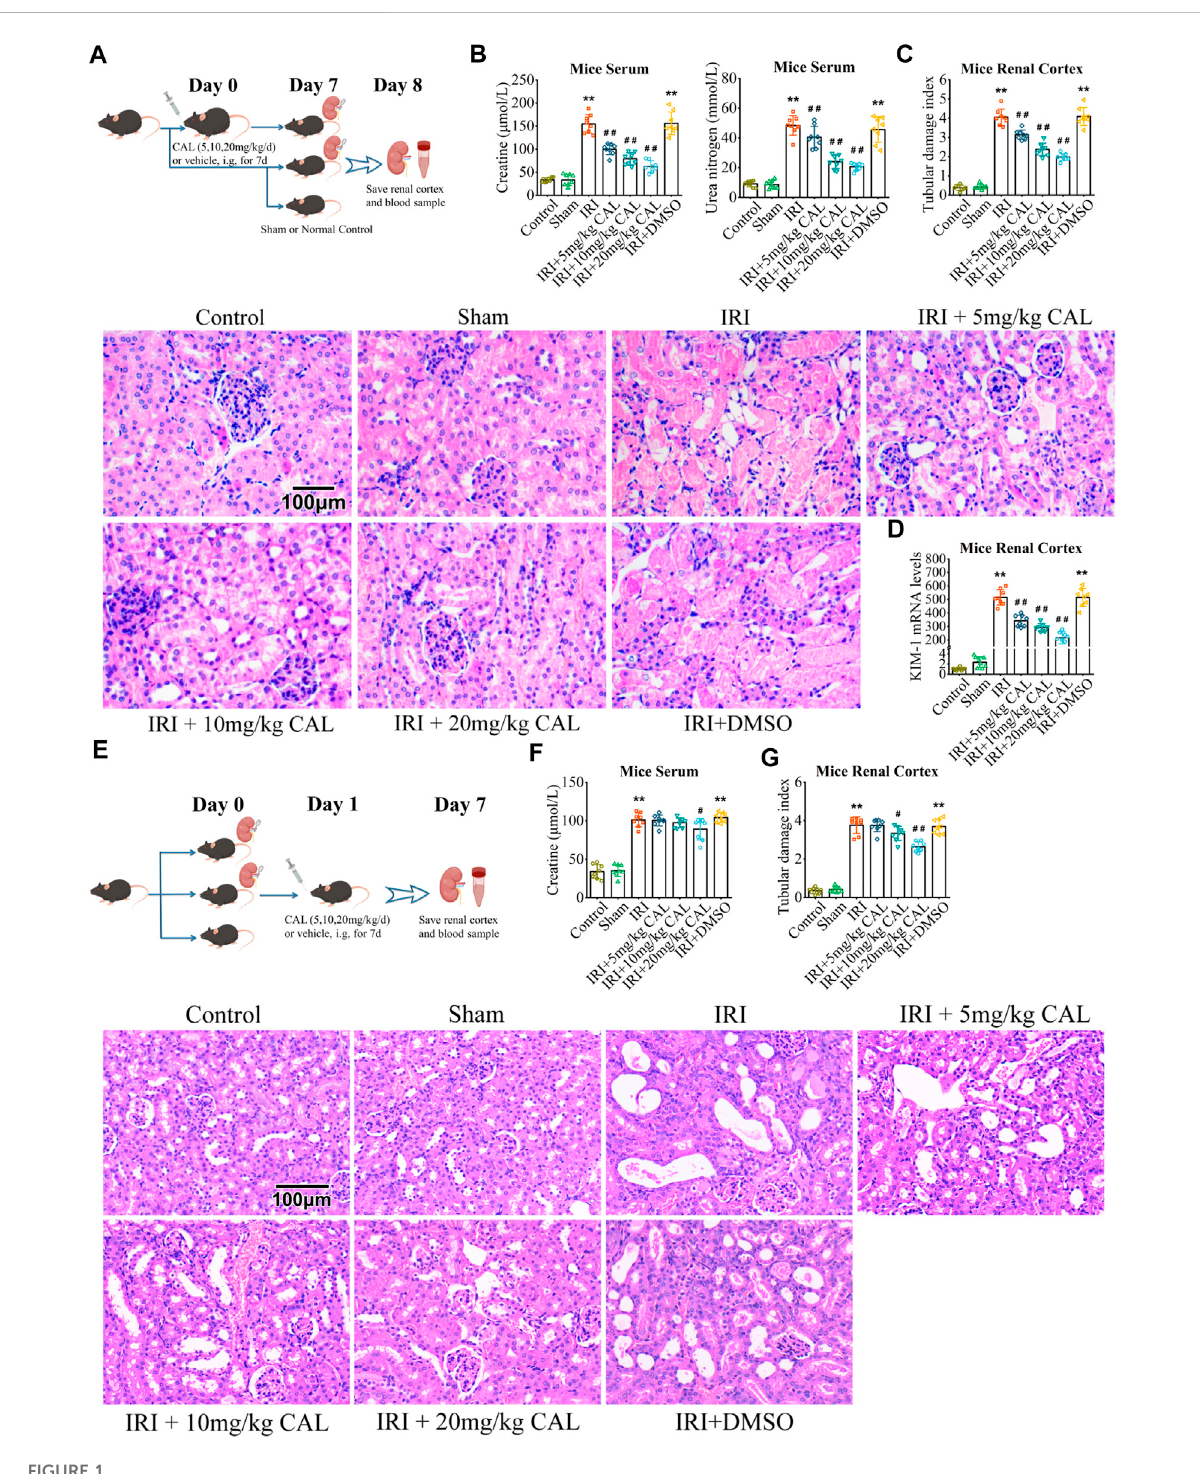
FIGURE 1 CAL protected the kidney from IRI. (A) The pattern diagram of the animal research design for CAL pre-treatment. (B) SCr and BUN levels in kidney samples of different groups. (C) Renal tubular damage index and H and E staining images of kidney tissue samples in different groups. Scale bar, 100 µm. (D) KIM-1 mRNA level in kidney samples of different groups. ** p < 0.01 vs. sham group. ## p < 0.01 vs. IRI group. n = 8 per group. (E) The patterndiagramoftheanimalresearchdesignforCALpost-surgeryadministration. (F) SCrlevel inkidney samplesofdifferentgroups. (G) Renal tubular damage index and H and E staining images of kidney tissue samples in different groups. Scale bar, 100 µm. ** p < 0.01 vs. sham group. # p < 0.05, ## p < 0.01 vs. IRI group. n = 8 per group. The data are presented as the mean ±